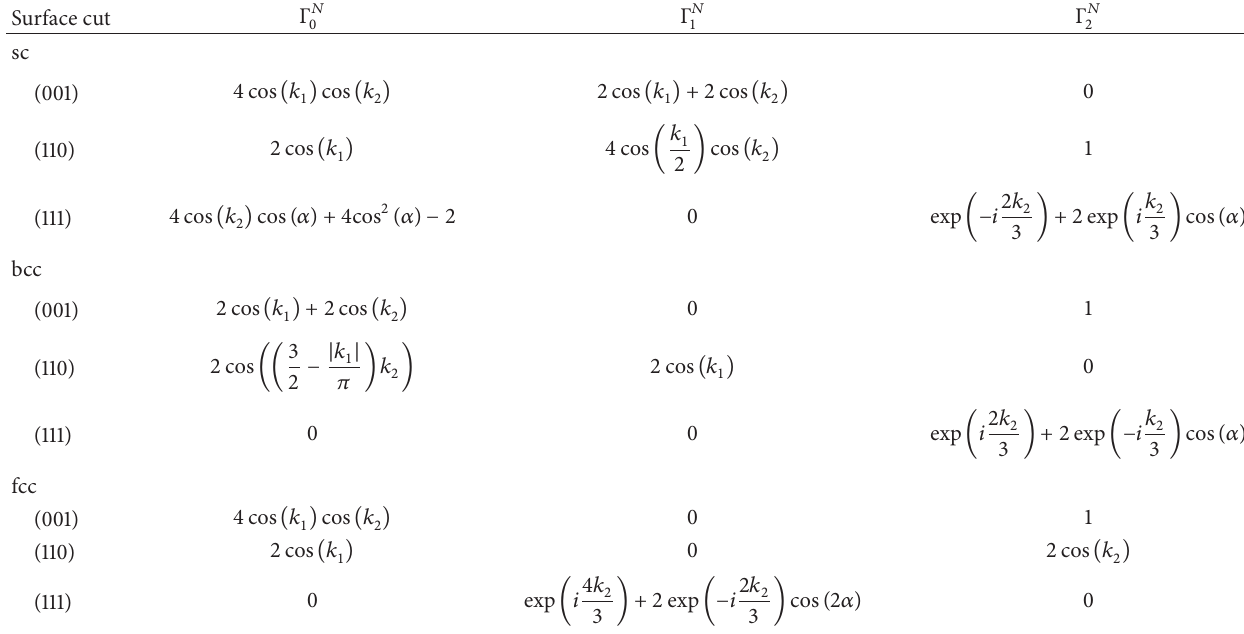
Table 3: Structural sums Γ 𝑁 𝑛 for next nearest neighbors disposed in adjacent lattice planes 𝑙 ± 𝑛 , 𝑛 = 0, ...,2 , parallel to the surface in thin films considered in the